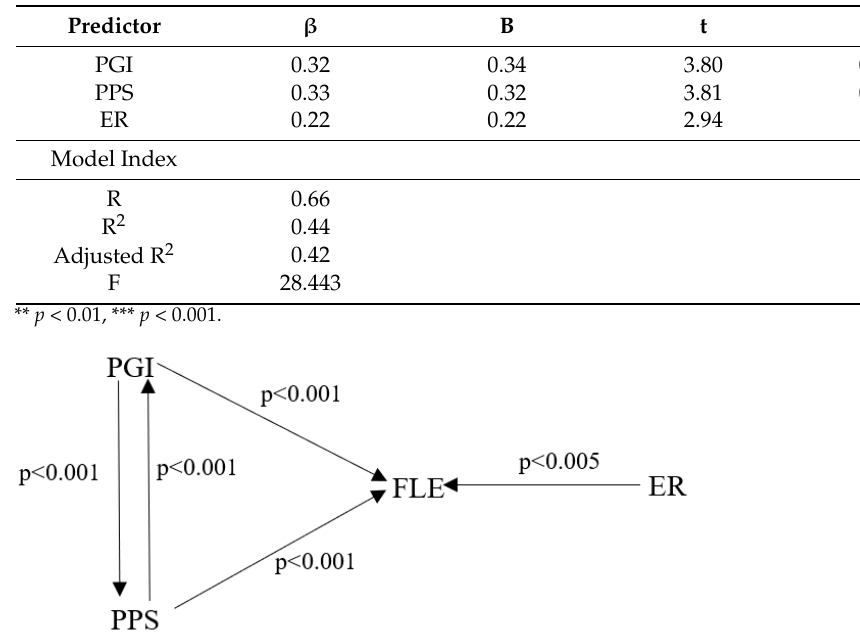
Table 2. Linear regression analysis for variables predicting FLE.